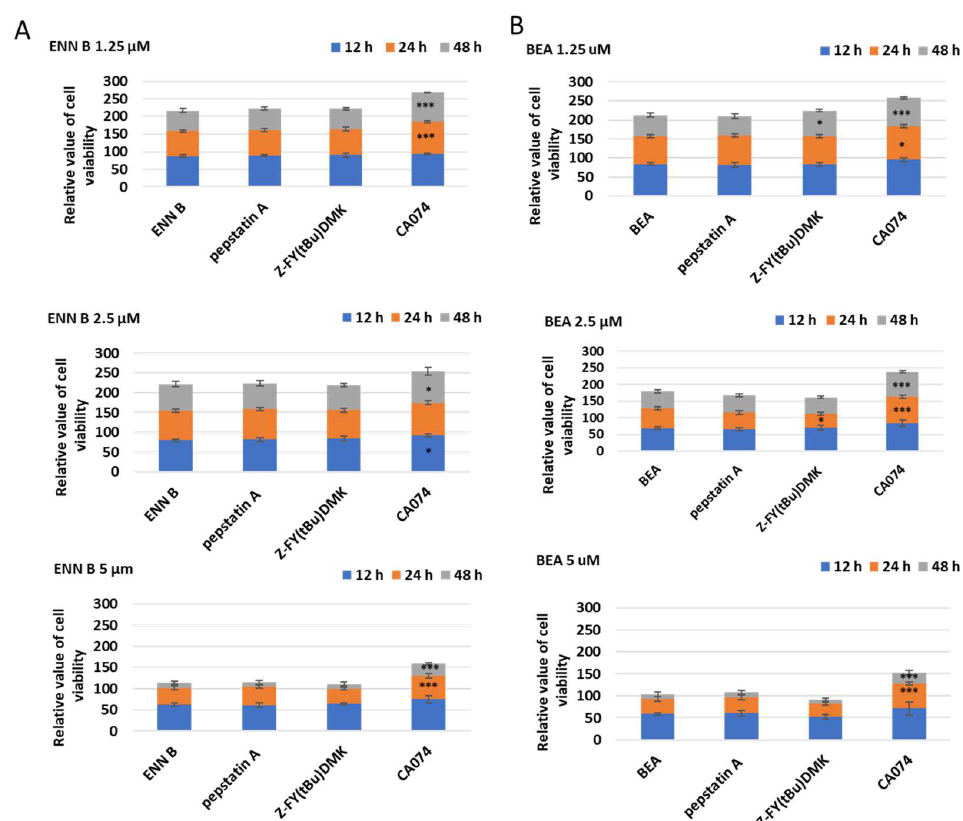
Figure 13. The effect of cathepsins B, D, or L inhibition on ENN B or BEA cytotoxicity. ( A ) Cells were treated with different concentrations of ENN B in the presence or absence of different cathep- sin inhibitors. ( B ) Cells were treated with different concentrations of BEA in the presence or absence of cathepsins inhibitors. The data were analyzed using two-way ANOVA with Dunnett’s post hoc analysis (* p < 0.05; *** p < 0.001; N = 7). Statistics were calculated using GraphPad Prism.